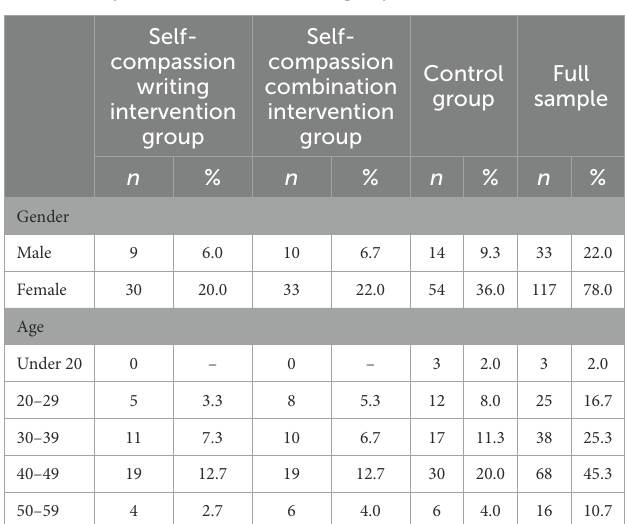
TABLE 1 Sample distribution of the three groups ( N =